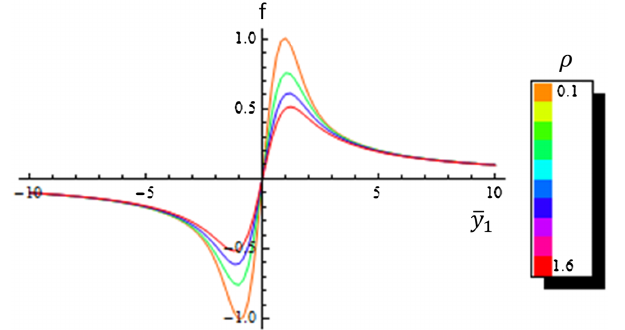
FIG. 3. Profile on axis ¯ u 1 ¼ 0 . The maximum f locates at ¯ y ¼ 1 . 1